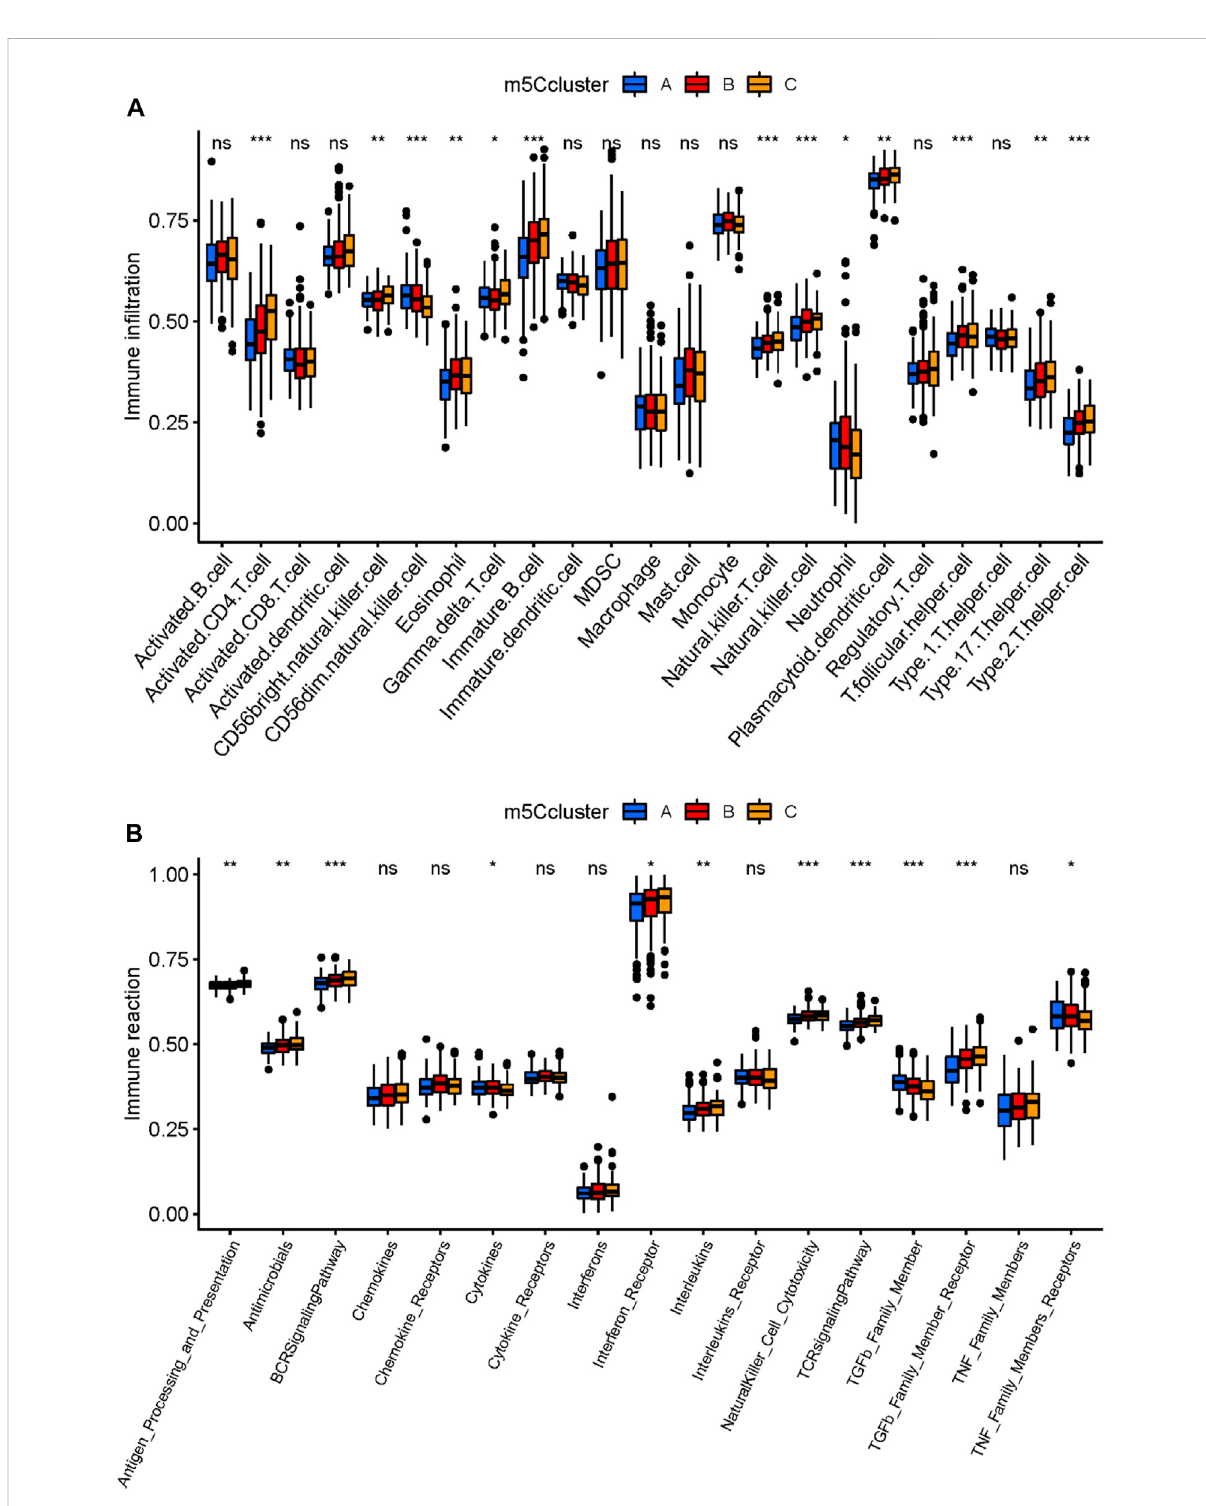
FIGURE 5 Immune characteristics of the three distinct m 5 C clusters. (A) Abundance of in fi ltrating immune cells in the three m 5 C modi fi cation clusters. (B) Differences in the 17 immune response reactions between the three m 5 C modi fi cation clusters. * p < 0.05; ** p < 0.01; *** p <